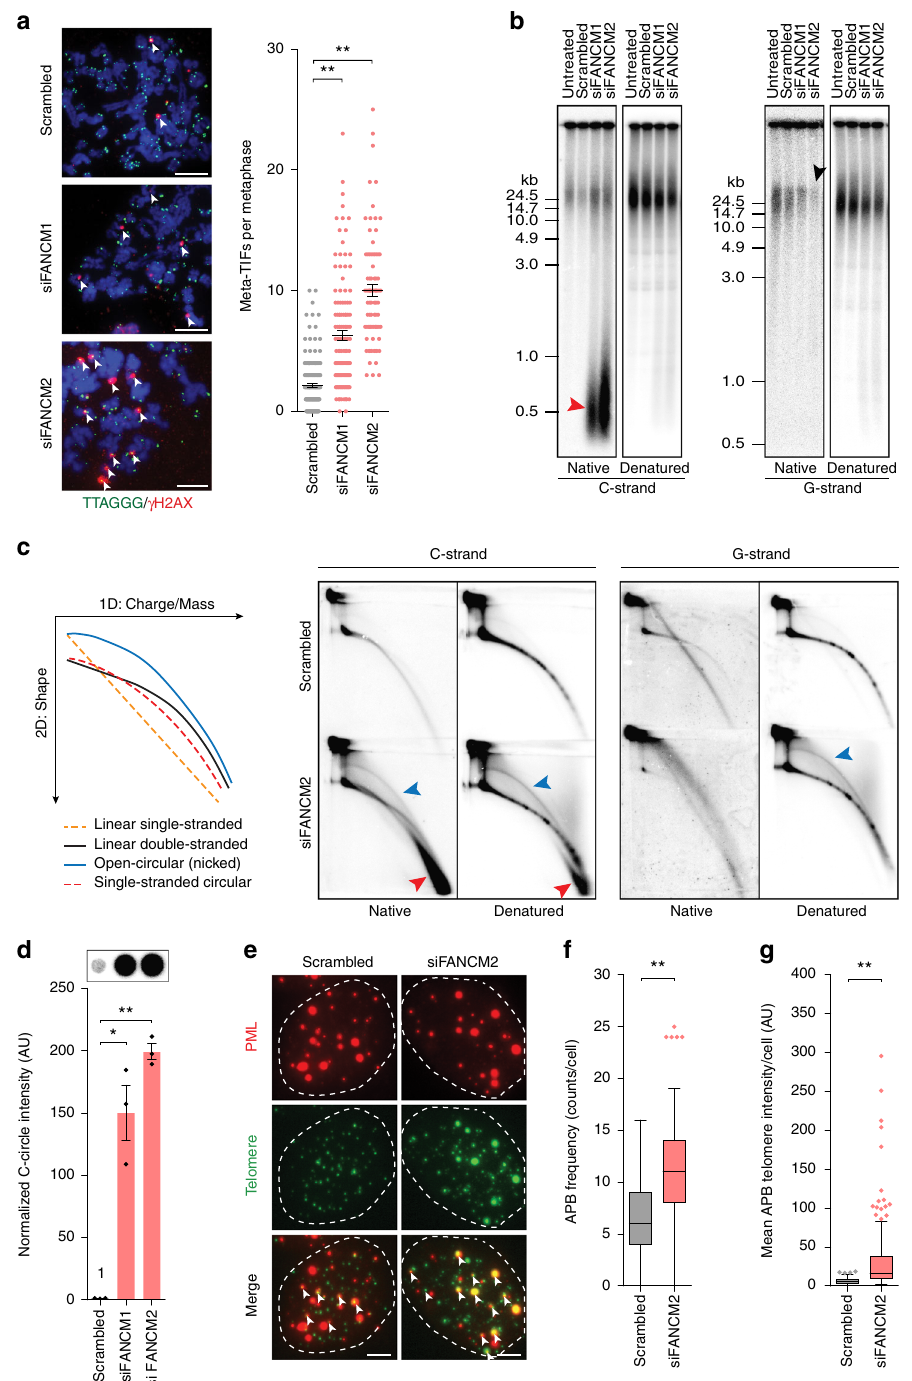
Fig. 1 FANCM depletion results in telomere dysfunction and increased ALT activity. a Representative images of telomere (green) and γ -H2AX (red) colocalizations on metaphase spreads (meta-TIFs) in U-2 OS cells with or without FANCM depletion (left panel). Meta-TIFs are indicated by white arrows. Scale bars are 5 μ m. Quantitation of TIFs (right panel). Scatterplot bars represent the mean ± SEM. Out of three experiments, n ≥ 81 metaphases scored per treatment, ** p < 0.005, Mann – Whitney test. b Native and denatured TRF analysis of U-2 OS cells with or without FANCM depletion. Colored arrows correspond to telomeric DNA species depicted in c . c Schematic of migration patterns for indicated telomeric species separated by two-dimensional gel electrophoresis (left panel). Two-dimensional TRF analysis of U-2 OS cells with or without FANCM depletion, hybridized under native and denatured conditions to detect the telomeric C-strand and G-strand (center and right panels). Colored arrows correspond to telomeric DNA species depicted in schematic. d Representative dot blot and quantitation of C-circle assays in U-2 OS cells with or without FANCM depletion. C-circle levels were normalized to the mean of scrambled control. Error bars represent the mean ± SEM from n = 3 experiments, * p < 0.05, ** p < 0.005, Student ’ s t -test. e Representative images of telomere (green) and PML (red) colocalizations (APBs) in FANCM-depleted U-2 OS cells. APBs are indicated by white arrows. Scale bars are 5 μ m. Tukey box plots of f APB frequency and g mean APB telomere foci intensity per cell. Out of three experiments, n ≥ 150 cells scored per treatment, * p < 0.05, ** p < 0.005, Mann – Whitney